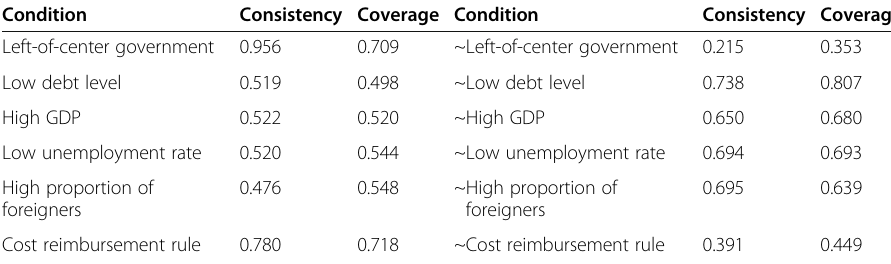
Table 1 Test for the necessary conditions for the “ Introduction of the alternative model ” outcome